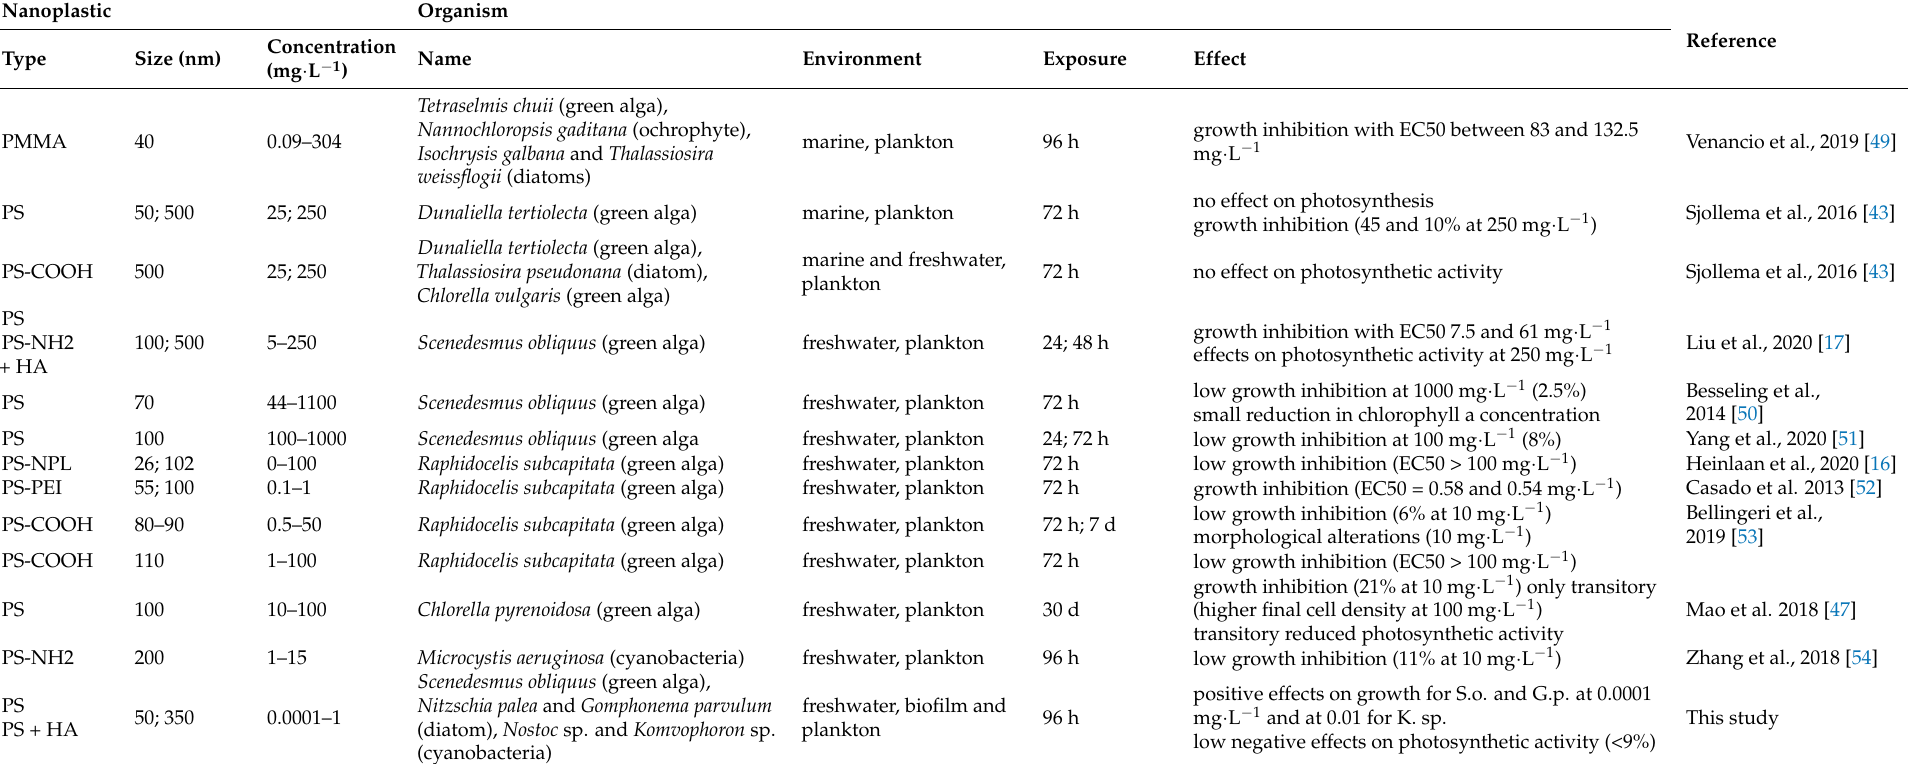
Table 2. Summary of different assessments of the toxicity of plastic nanoparticles on